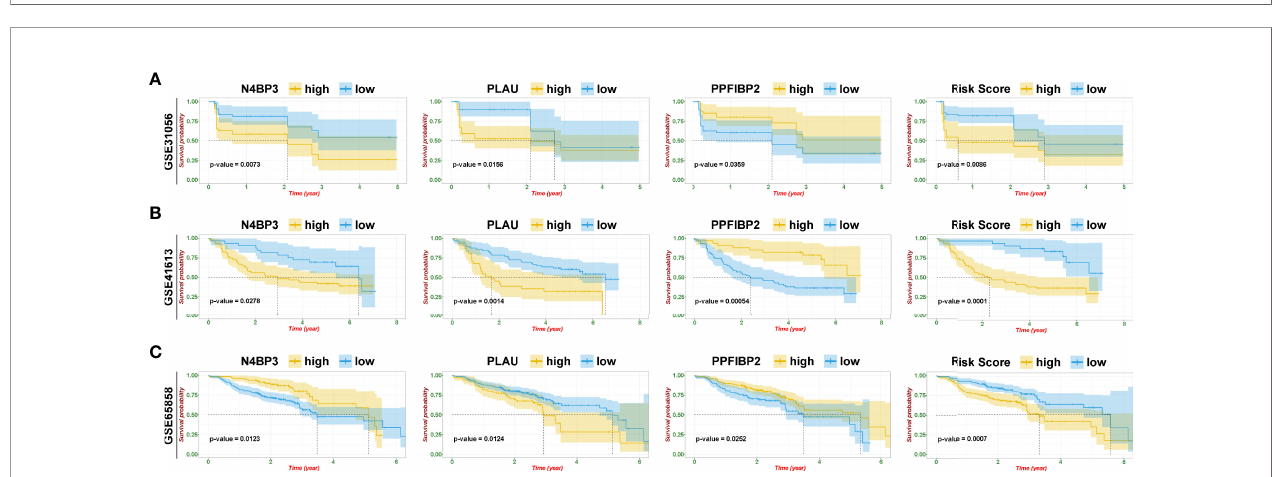
FIGURE 5 | Immune characteristics. (A) Heatmap of crucial genes and ESTIMATE scores. (B) Differential expression of stromal, immune, and ESTIMATE scores. (C) Differential distribution of 22 tumor microenvironment in fi ltrating cells in two clusters (*** p < 0.001; ** p < 0.01; * p < 0.05).